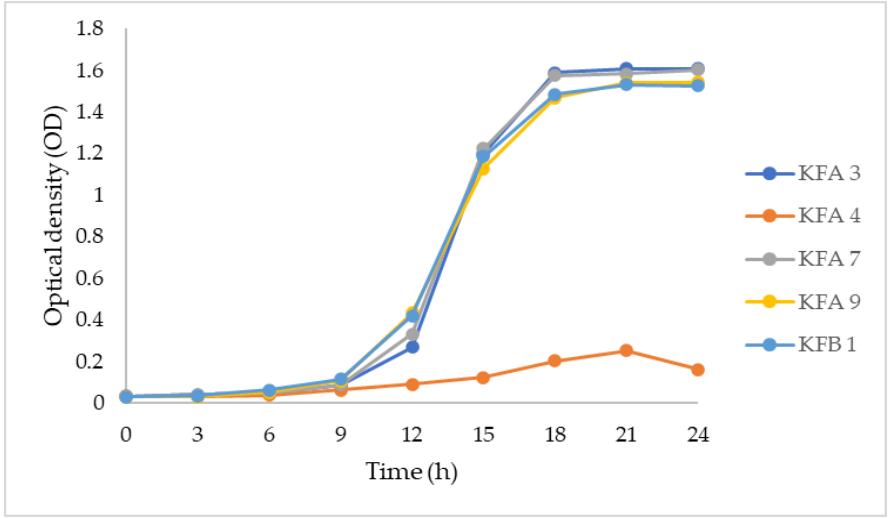
Figure 2. Growth pattern of K. marxianus (KFA 3, KFA 7, KFA 9 and KFB 1) and P. kudriavzevii (KFA 4) on lactose-containing